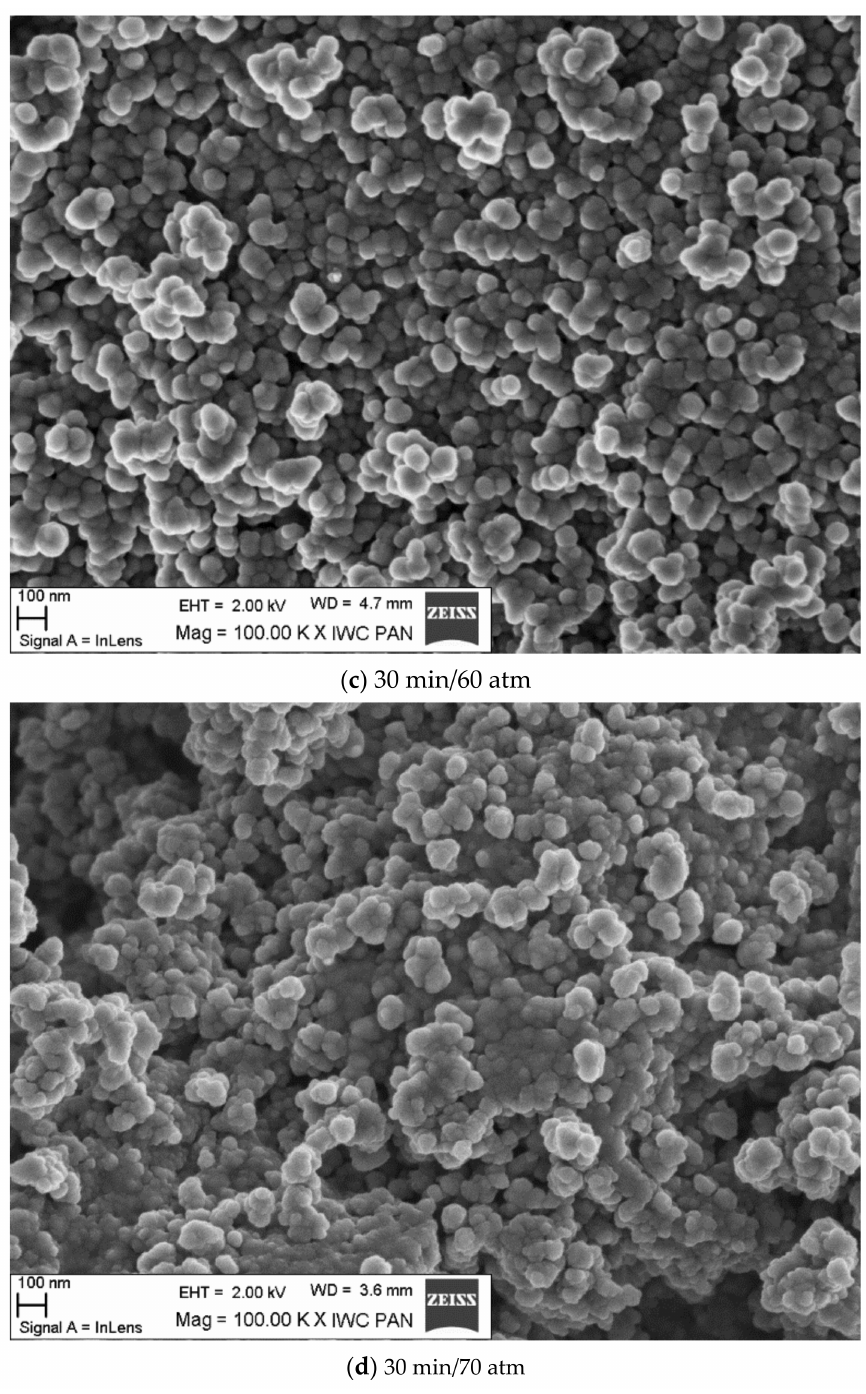
Figure 5. SEM pictures of samples obtained at the optimum process time of 30